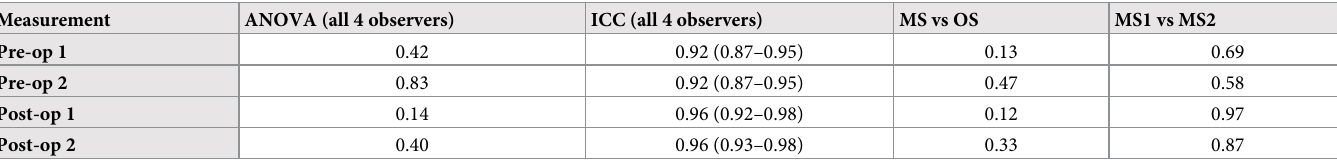
Table 4. Comparison of measurements performed by Medical Students (MS) and Orthopaedic Surgeons (OS).